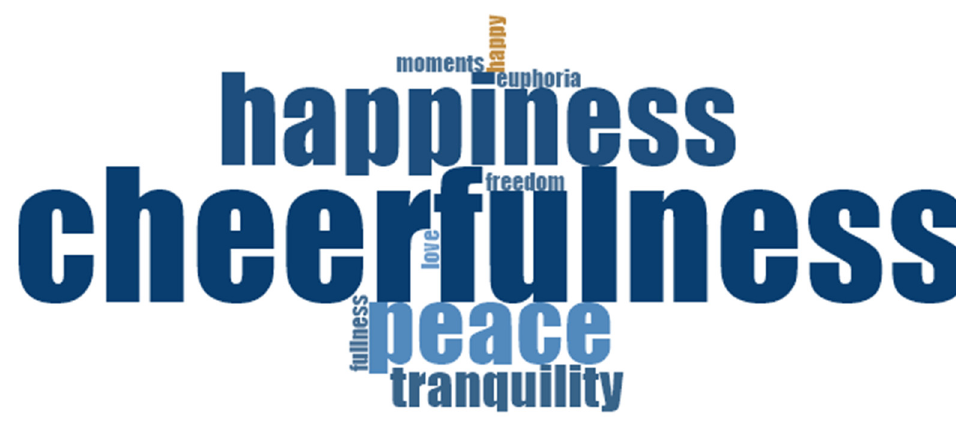
Figure 3. Positive emotions related to happiness: word cloud.